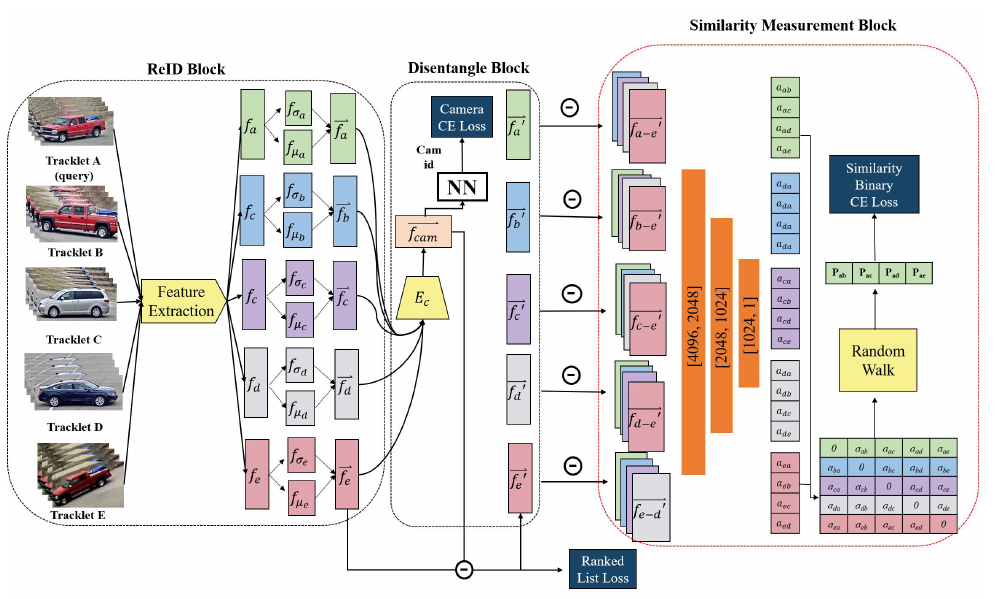
Figure 3. The architecture of the Tracklet Similarity